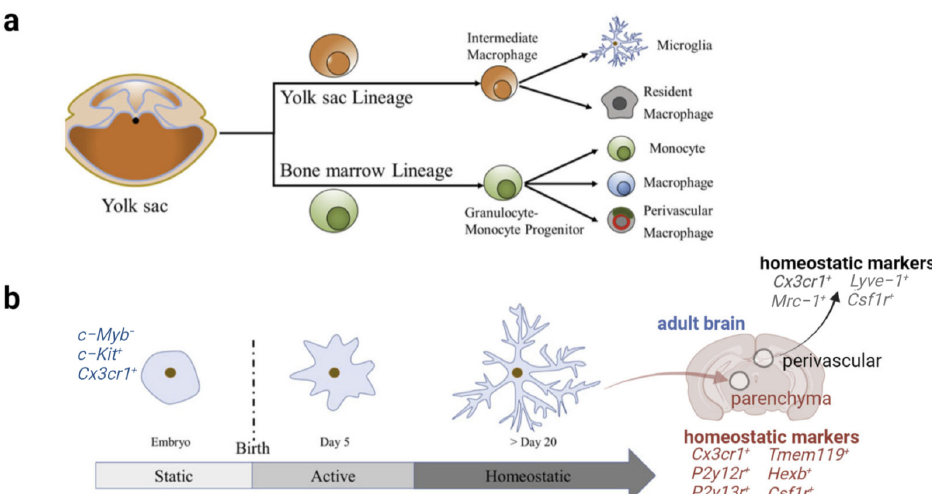
Figure 1. The origin of microglia and morphological changes during development and throughout adult mouse brain. ( a ) Microglia originate from the yolk sac and eventually mature following the development of intermediate macrophages. ( b ) Immature microglia from the embryonic period develop into homeostatic microglia 28 days after birth. Immature microglia exhibit amoeboid-like morphology. Matured microglia show homeostatic, highly ramified morphology. Microglia in different states show distinct molecular signatures. Abbreviations: c–Myb , protein c myeloblastosis gene; c-Kit , receptor tyrosine kinase gene; Cx3cr1 , C-X3-C motif chemokine receptor 1 gene; P2y12r , purinergic receptor P2Y12 gene; P2y13r , purinergic receptor P2Y13 gene; Tmem119 , transmembrane protein 119 gene; Hexb , beta-hexosaminidase subunit beta gene; Csf1r , colony-stimulating factor 1 receptor gene; Mrc–1 , mannose receptor c-type 1 gene; Lyve-1 , lymphatic vessel endothelial hyaluronan receptor 1 gene.